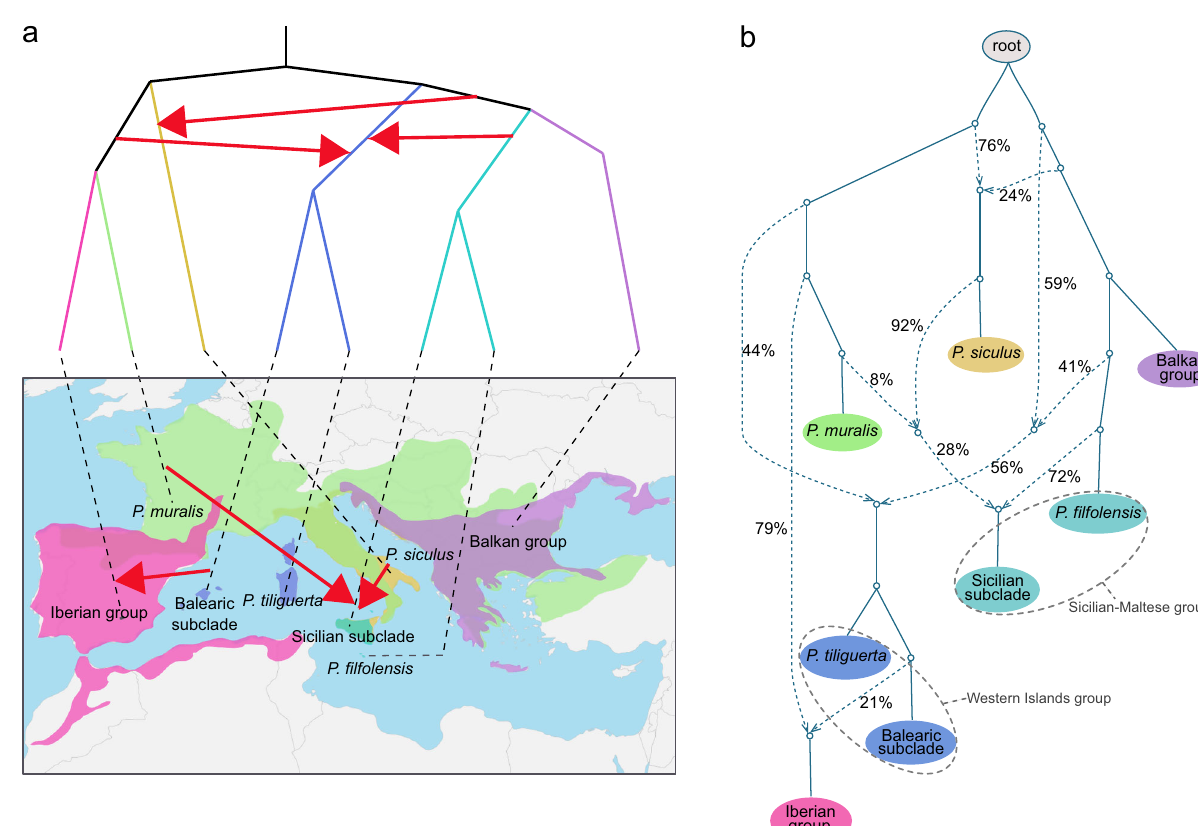
Fig. 3 Extensive genetic exchange among major wall lizard lineages. a A phylogram indicating the phylogenetic relationship among the six major groups of wall lizards and a map showing their geographic distributions. Note that the tree includes the splits within the Western Islands group and the Sicilian- Maltese group that are relevant for the origin of the mosaic genomes of island species. Red arrows indicate the introgression events. b The qpGraph of the major clades of wall lizards. The solid line represents the ‘ tree-like ’ evolution, whereas the dashed lines with arrows represent the parental ancestry of reticulations. The numbers next to dashed lines indicate the percentage of alleles derived from a given introgressive hybridization. For the corresponding illustration of genetic exchange within the major clades, see Supplementary Fig.